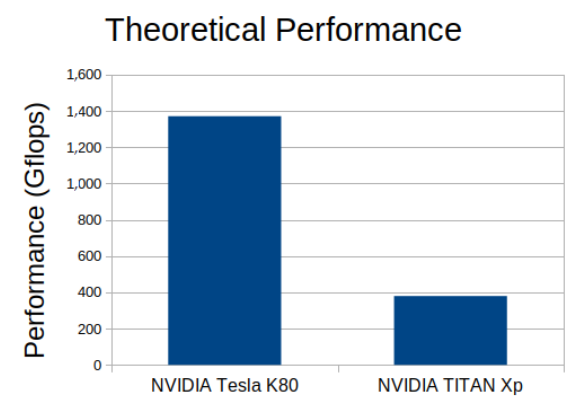
Figure 13. NVIDIA K80 vs. NVIDIA TITAN